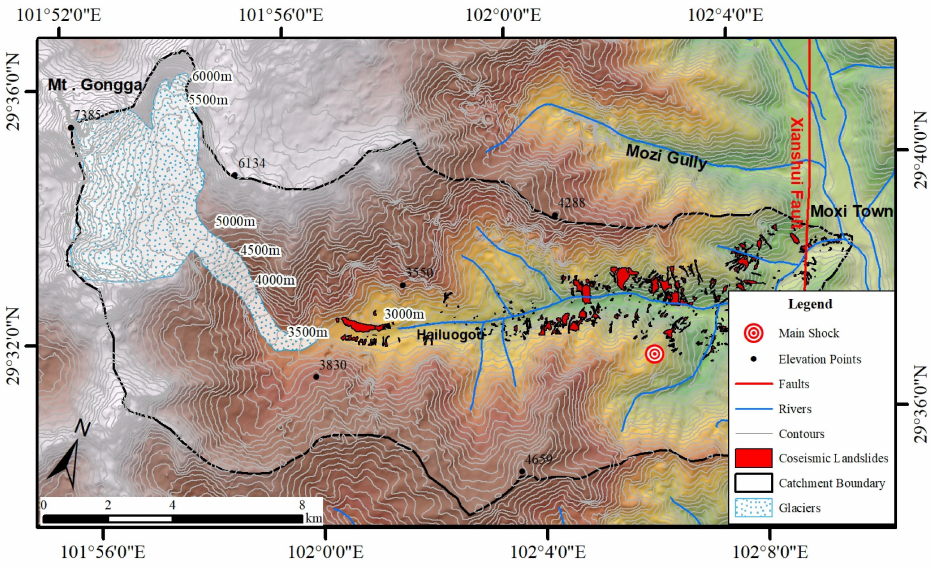
Figure 2. Geomorphologic map of Hailuogou catchment area. The elevation ascends from the east (1500 m) to the west (7556 m). The Hailuogou Glacier is located at the northwestern corner of the catchment area, while the east is mainly gullies.